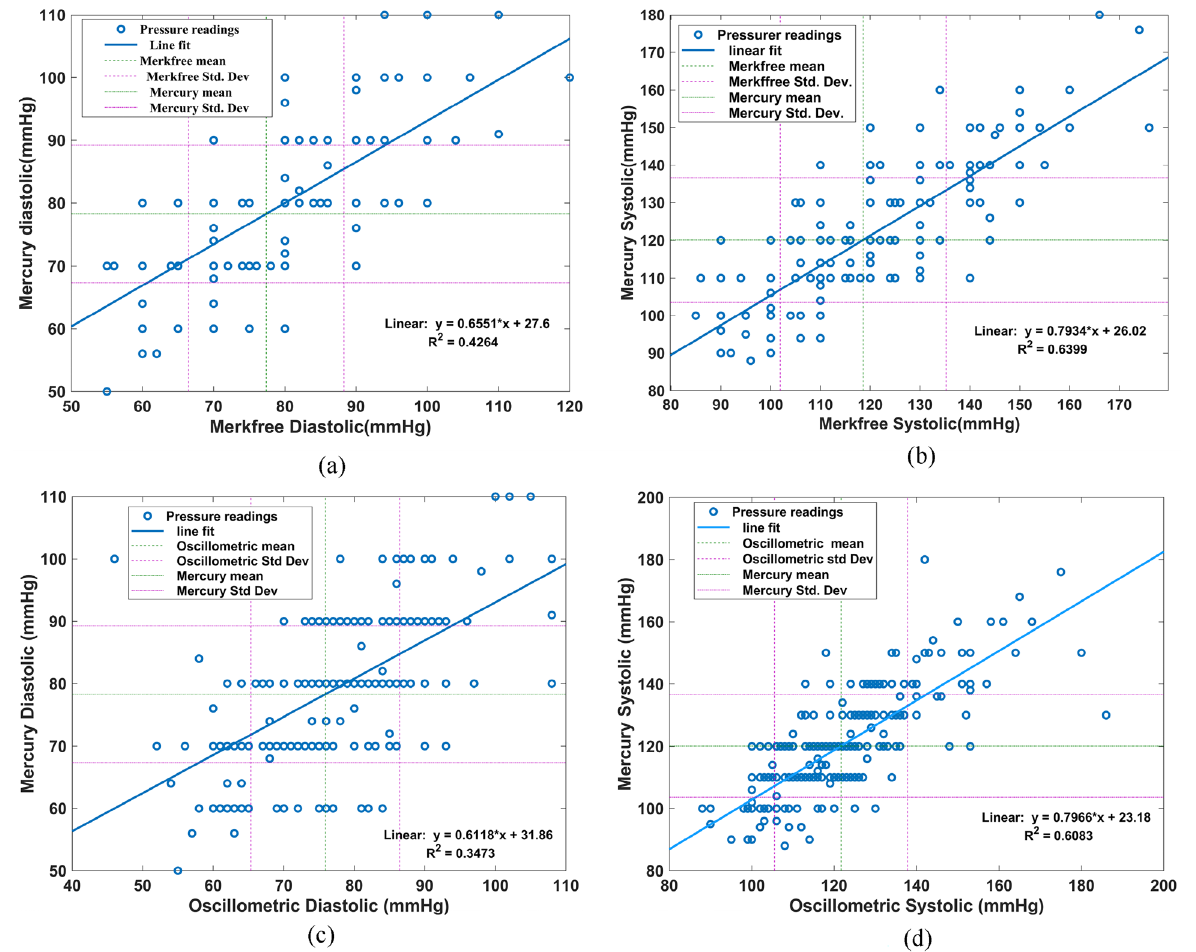
Figure 5. Comparison of blood pressure readings: ( a ) DBP readings of Mercury versus Merkfree, ( b ) SBP readings of Mercury versus Merkfree, ( c ) DBP readings of Mercury versus Oscillometric, ( d ) SBP readings of Mercury versus